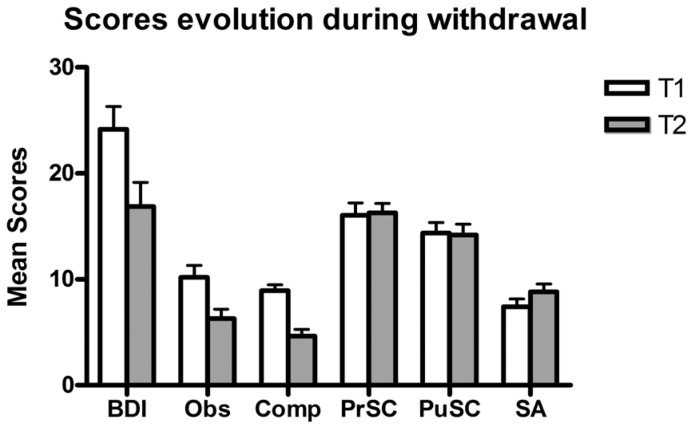
Evolution of scores of depression, craving and self consciousness during alcohol withdrawal.Depression scores were measured with the BDI (Beck et al., 1996; Bourque and Beaudette, 1982), obsessional (Obs) and compulsional (Comp) subscores of craving were measured by the OCDS (Anton et al., 1995, 1996; Ansseau et al., 2000), and self-consciousness were measured by the RSCS with subscores of Private (PrSC) and Public (PuSC) Self-Consciousness and Social Anxiety (SA) (Pelletier and Vallerand, 1990; Scheier and Carver, 1985) at both the onset (Time 1) and at the end (Time 2) of protracted withdrawal.